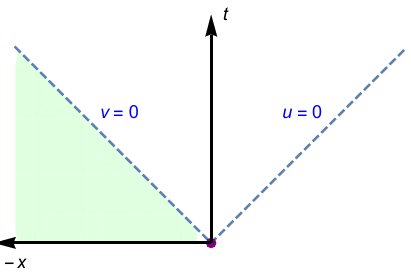
Figure 1. Con(cid:12)guration for solving the two-dimensional wave equation with initial data on a half line. Shaded is the future domain of dependence of the initial data. To obtain the solution outside of this domain of dependence requires additional data such as data on the boundary ( x = 0, t > 0), which are subject to corner conditions if the full solution needs to be